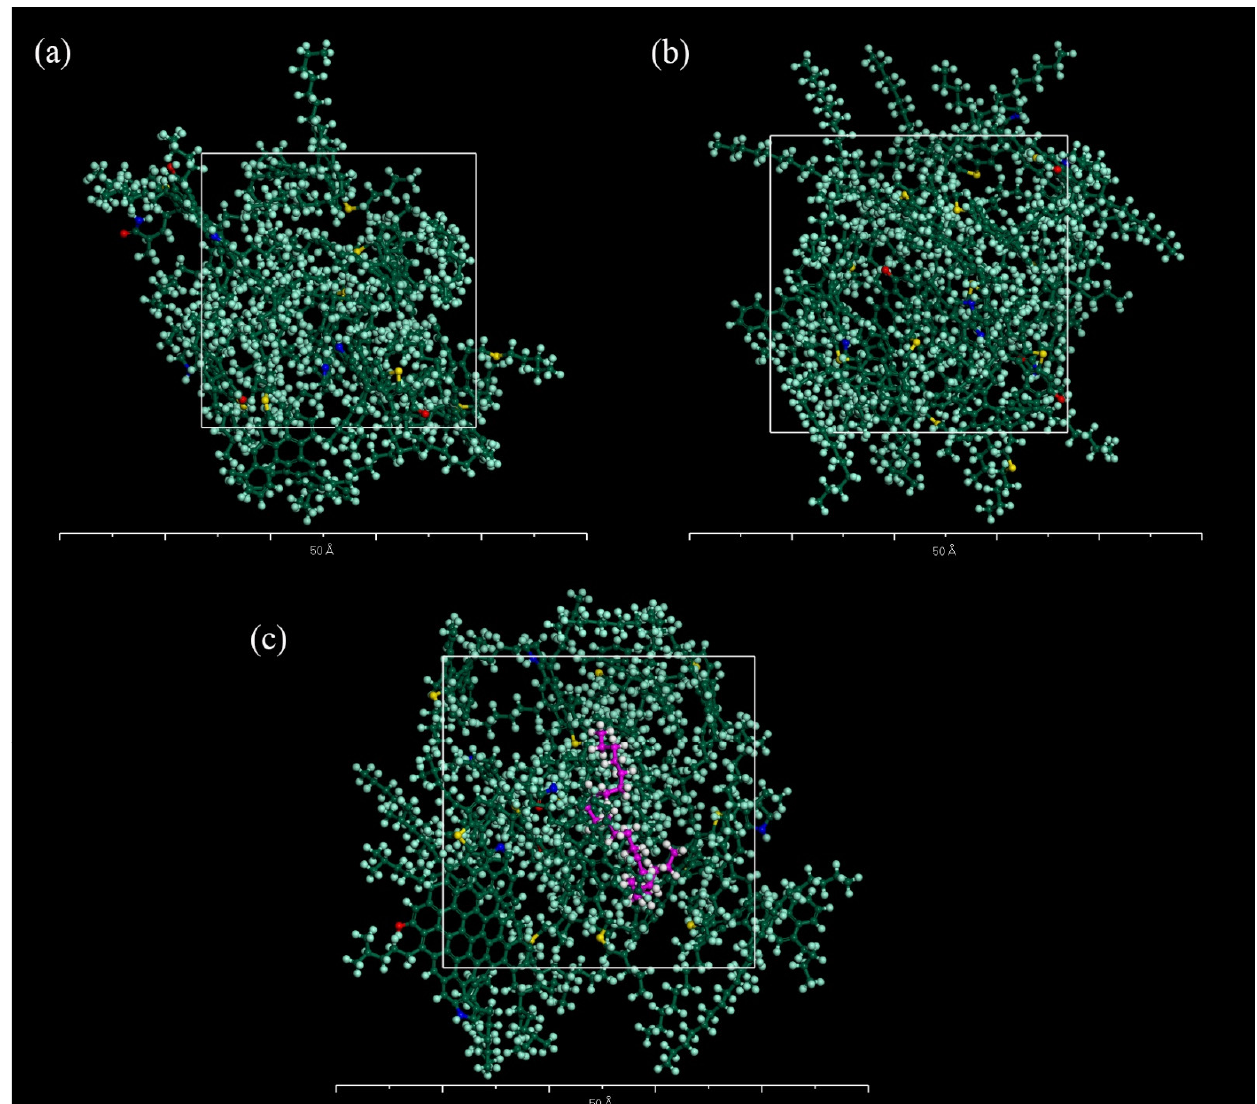
Figure 5. Models ( a ) original asphalt; ( b ) NR-modified asphalt; ( c ) PE/NR-modified asphalt.